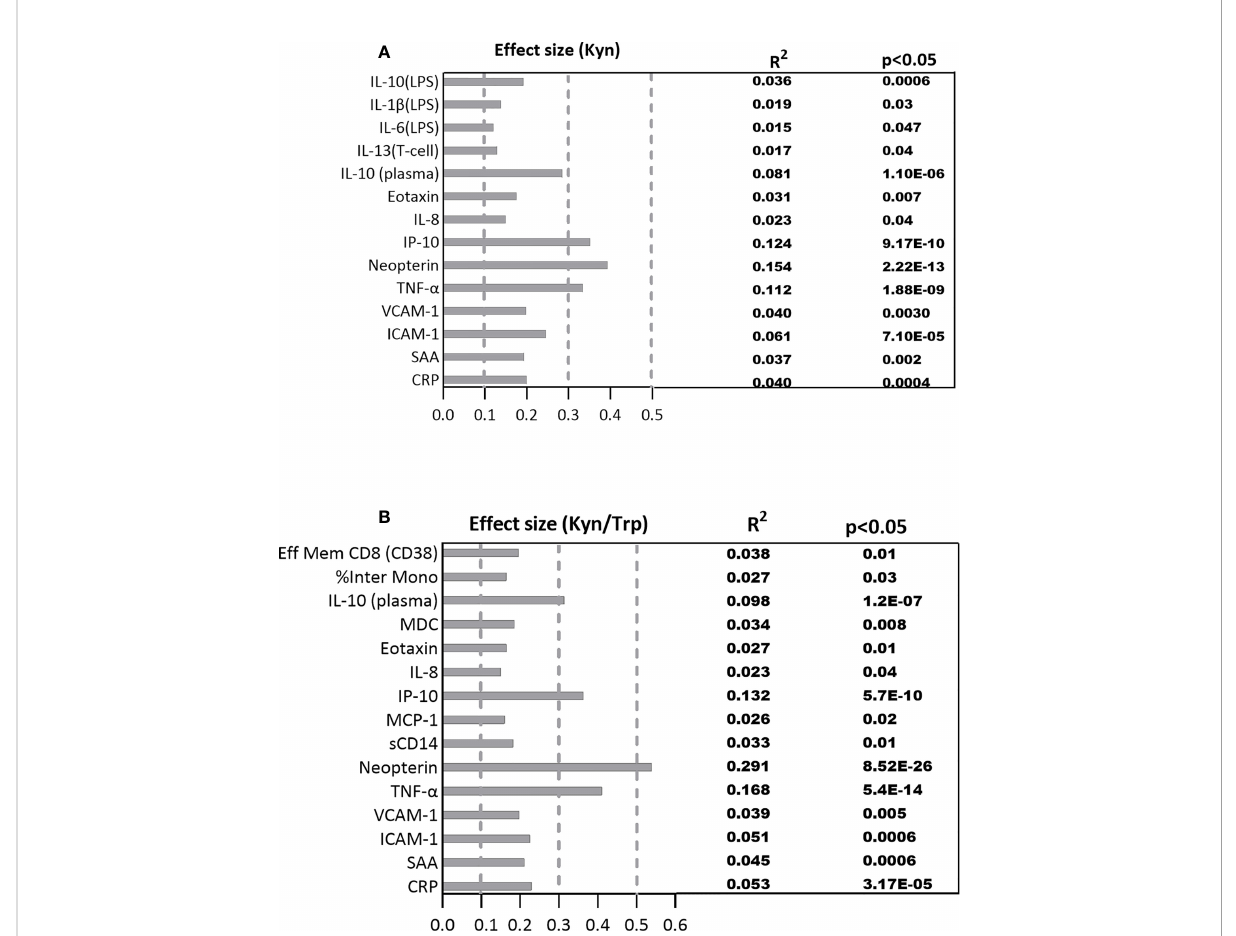
FIGURE 4 The standardized effect sizes, R², and p values for signi fi cant association between the immune biomarkers and (A) Kyn, (B) Kyn/Trp ratio. Dotted lines represent the range of the small (0.1-0.3), medium (0.3-0.5) and large (0.5-1)